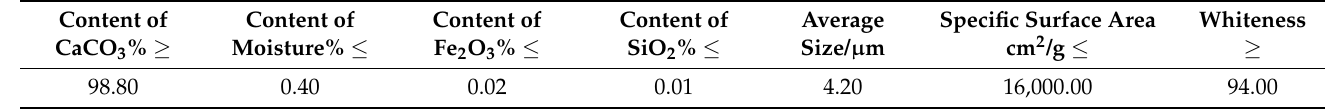
Table 1. Relevant information for the 1500 mesh heavy calcium carbonate.